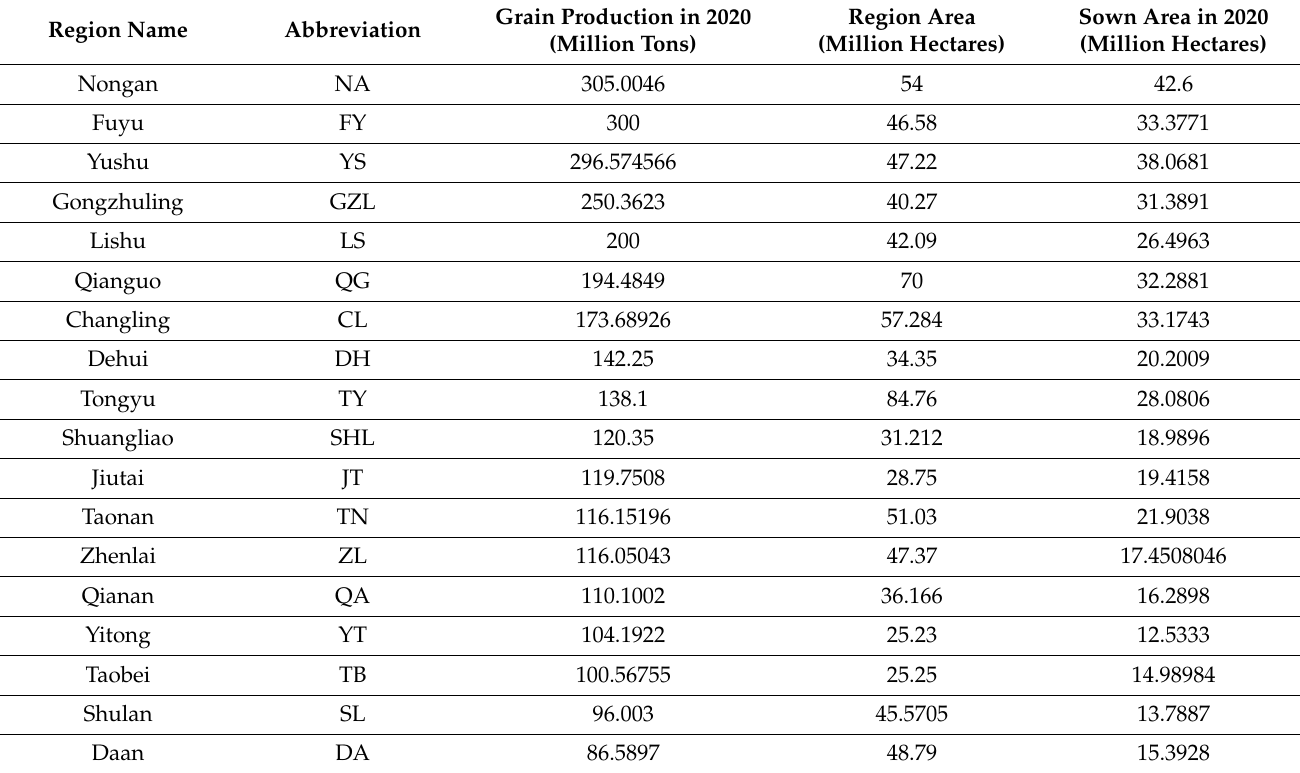
Table 1. Overview of the situation in each